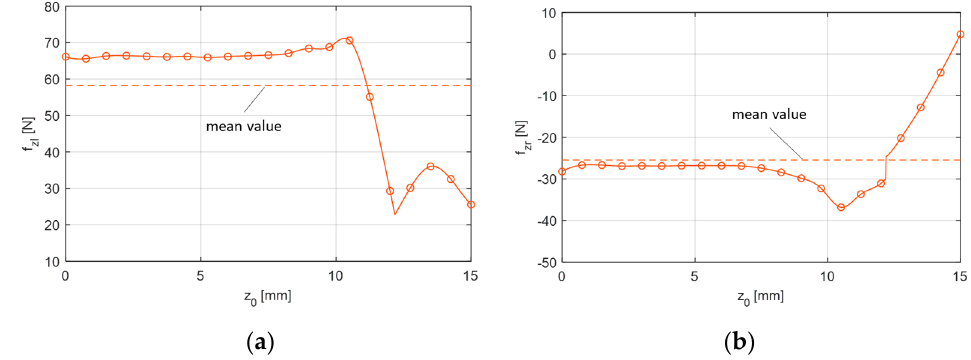
Figure 10. Thrust profiles as functions of the axial mover position for different ampere-turns; ( a ) LV mover; and ( b ) RV mover.